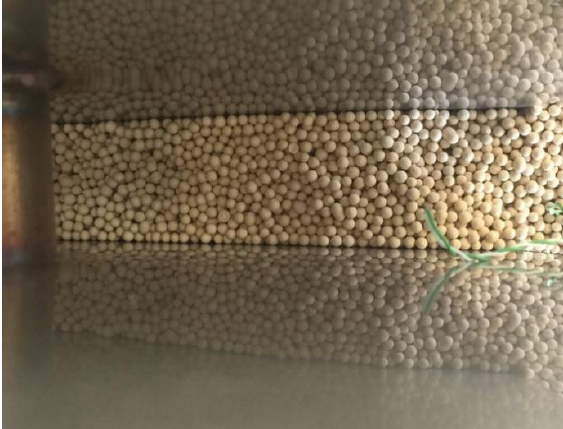
Figure 4. Thermocouple for temperature data acquisition within the zeolite bed.